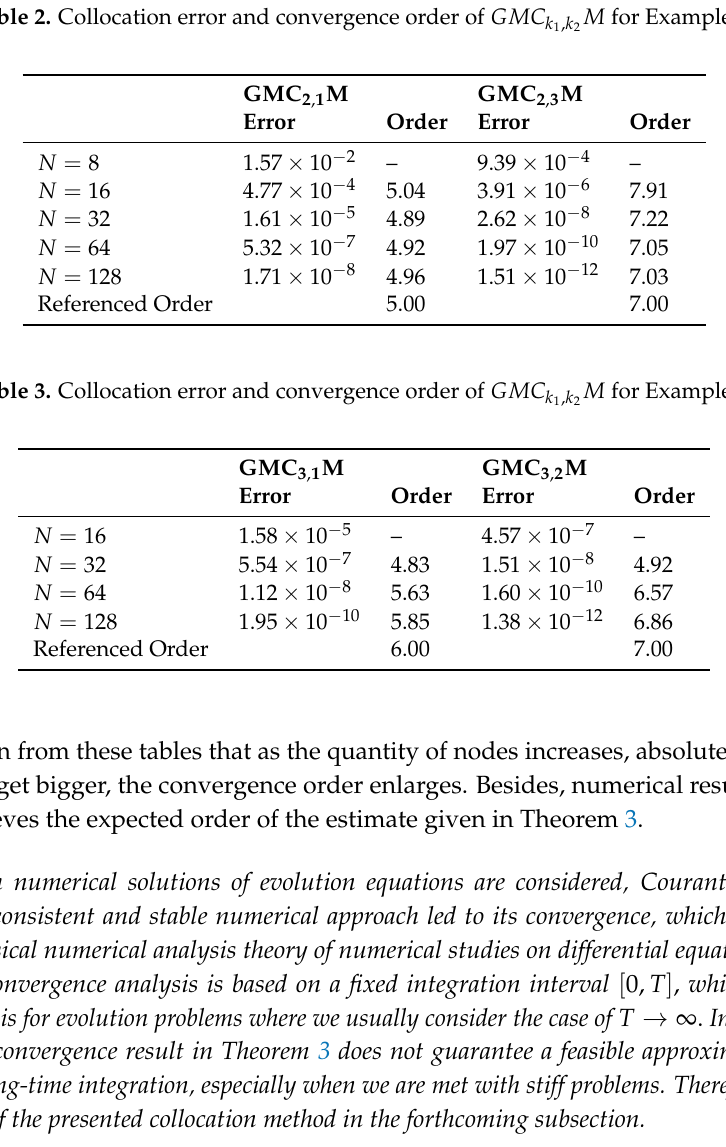
Table 2. Collocation error and convergence order of GMC k